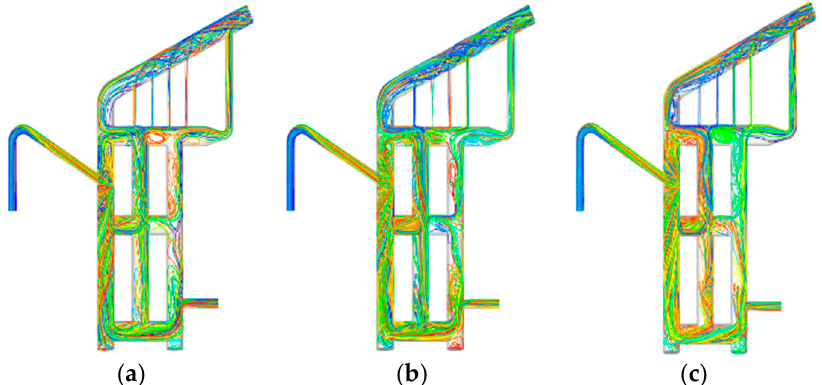
Figure 4. Effect of the water cut on the gas–liquid separation flow field characteristics. ( a ) 30%; ( b ) 40%; ( c ) 50%.